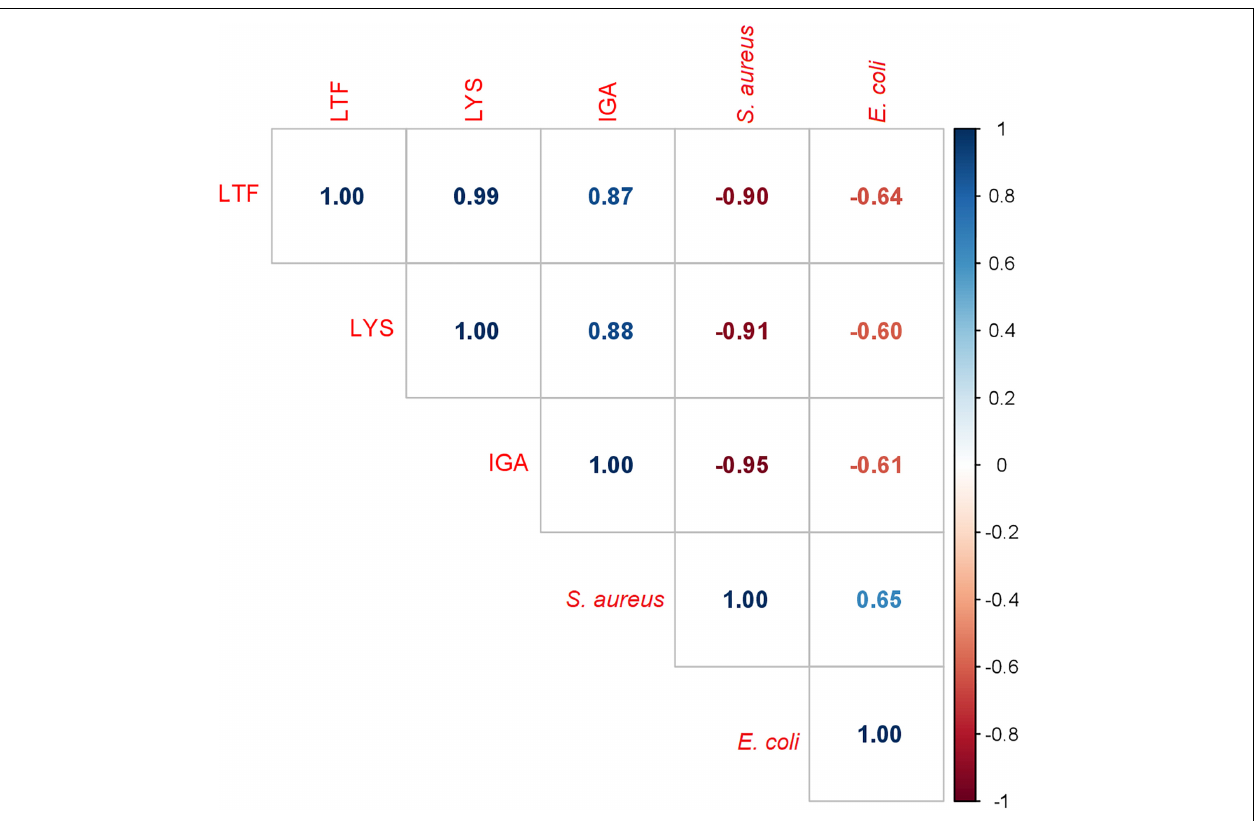
FIGURE 7 | Correlation matrix of S. aureus and E. coli growth rates and IgA, LTF and LYZ iBAQ values. Each box contains an r value (Pearson correlation